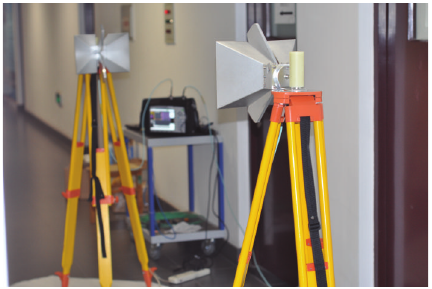
Figure 4: Measurement